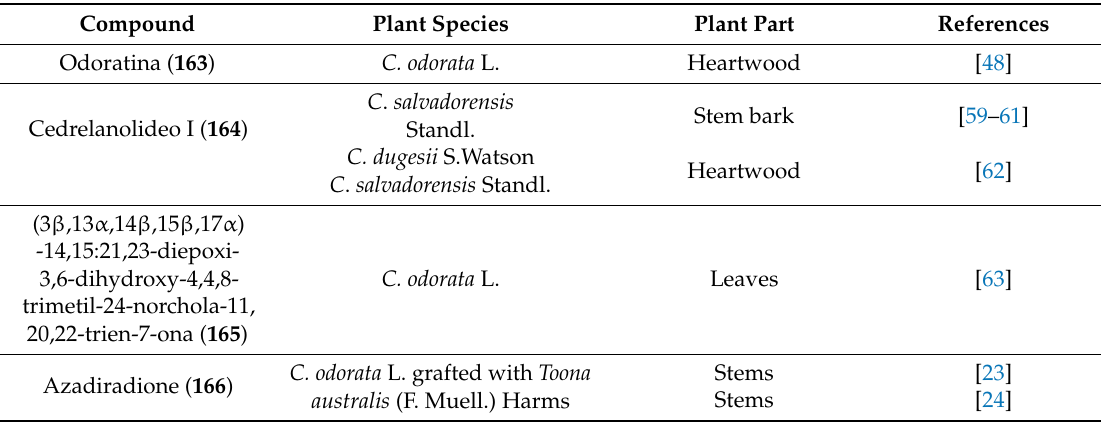
Table 9. Limonoids isolated from the genus Cedrela (1960–2020).